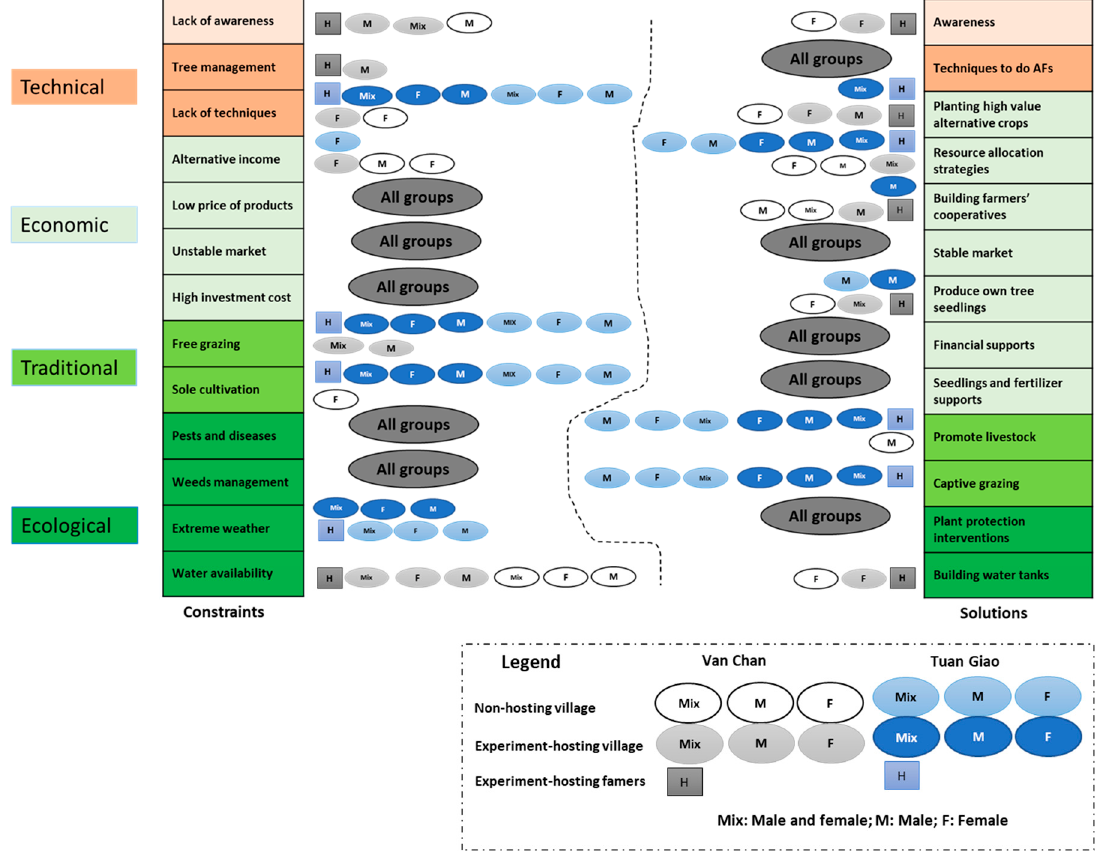
Figure 9. Farmers’ perceptions of constraints (left) and solutions (right) to the uptake of agroforestry (AF) in Van Chan and Tuan Giao, and (centre) the farmer groups that mentioned the respective constraint/solution. Open-ended questions were used in group interviews with non-hosting and experiment-hosting villages; experiment-hosting farmers were interviewed individually.